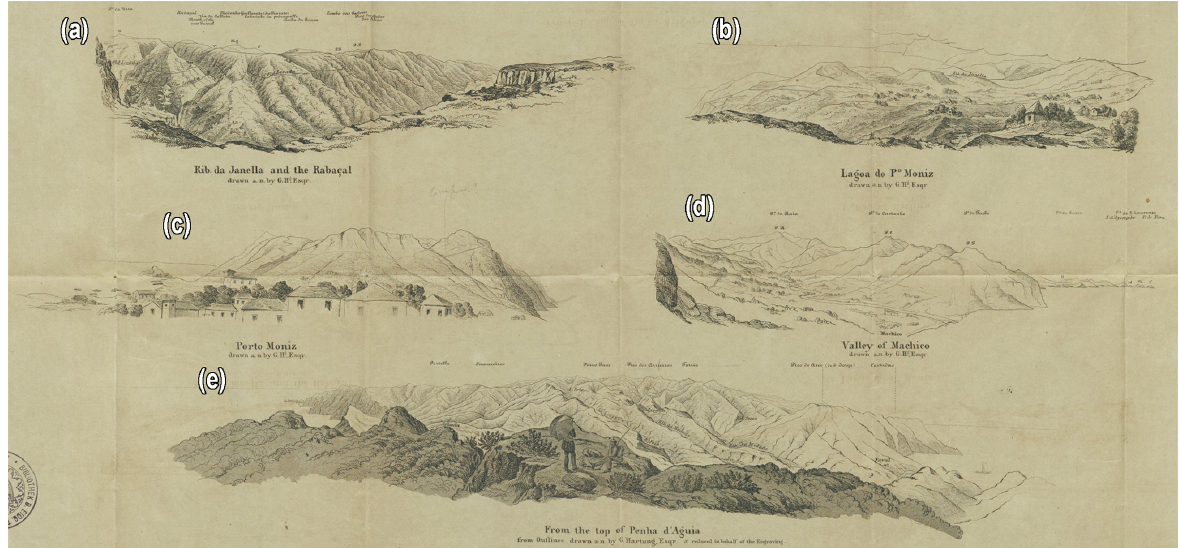
Figure 3. Panoramic views drawn by Georg Hartung printed on the back of the Ziegler et al. (1856) physical map of Madeira. (a) The Ribeira da Janela stream and Rabaçal locality. (b) The Lagoa do Fanal locality in Porto Moniz. (c) Porto Moniz village. (d) Machico and Ponta de São Lourenço in the eastern part of the island. (e) View from the of top Penha d’Águia (Porto da Cruz), showing the central part of the island. Note that the depicted persons are probably Hartung, holding an umbrella while sketching, and his local guide waiting for him. The image is public domain and was digitalized by ETH-Bibliothek Zurich (https://doi.org/10.3931/e-rara-38937, last access: 26 September 2021).